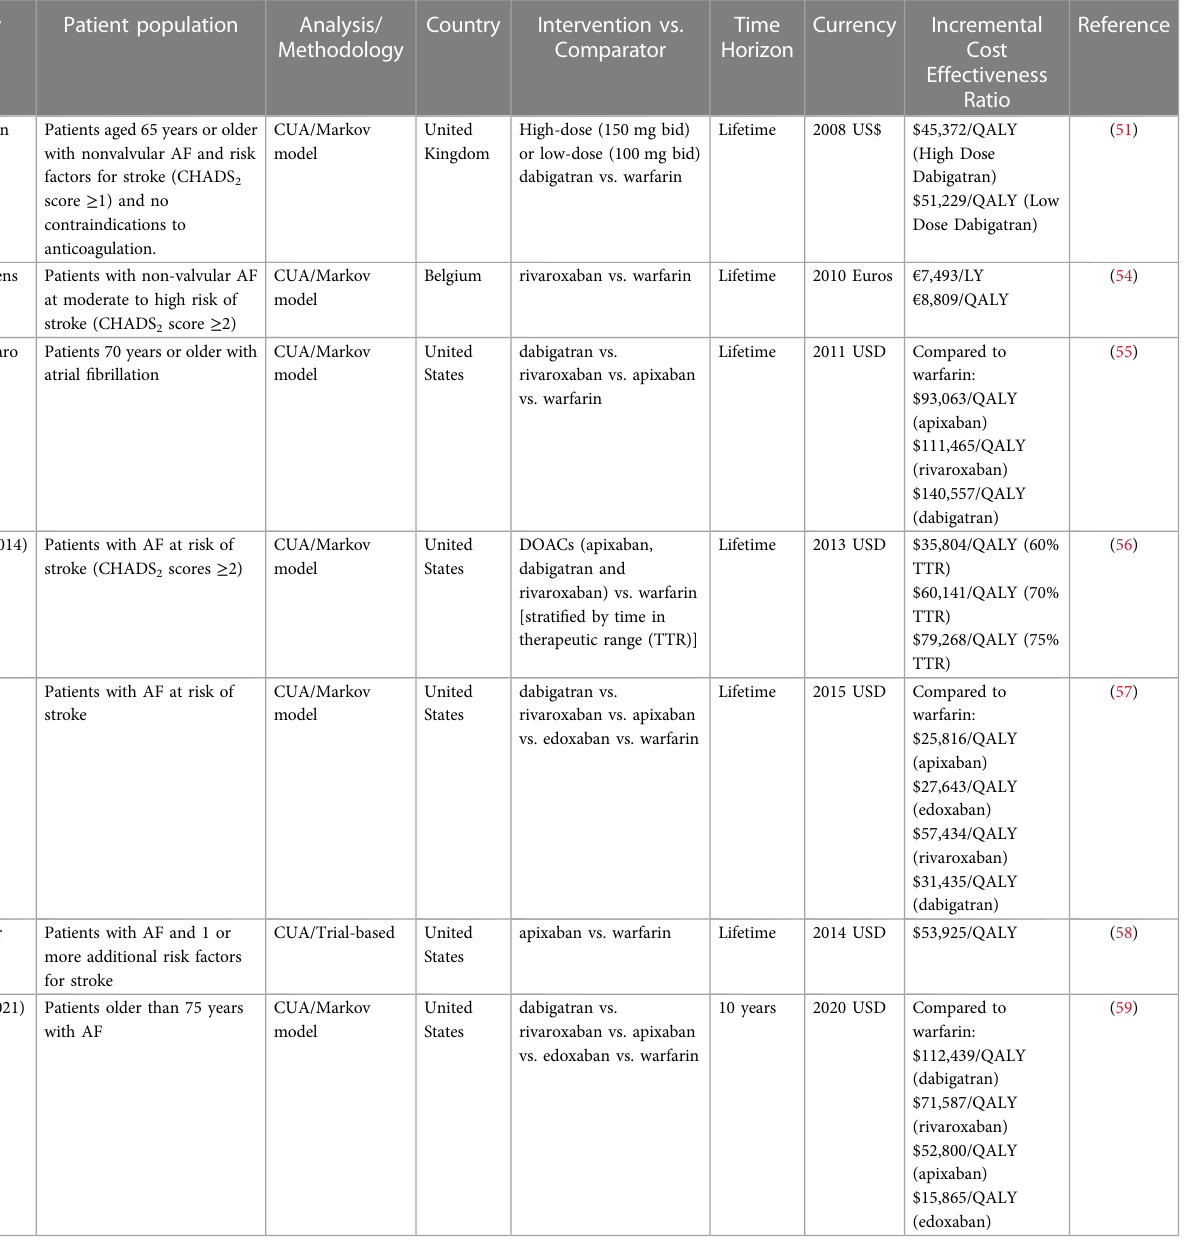
TABLE 3 Selected economic evaluations of anticoagulation for stroke prevention in atrial fi brillation. Study Patient population (Year)